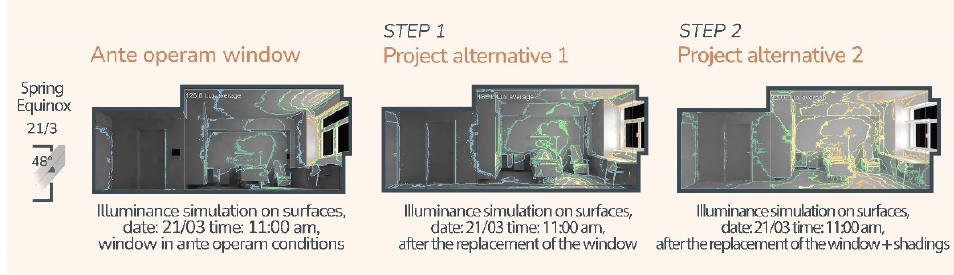
Figure 13. Room 1. Annual analysis of illuminance values on surfaces as a function of window design.